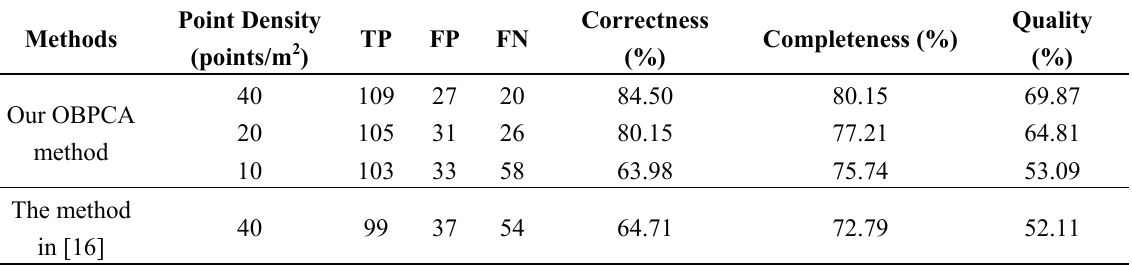
Table 1. Evaluation of two vehicle extraction methods. OBPCA, object-based point cloud